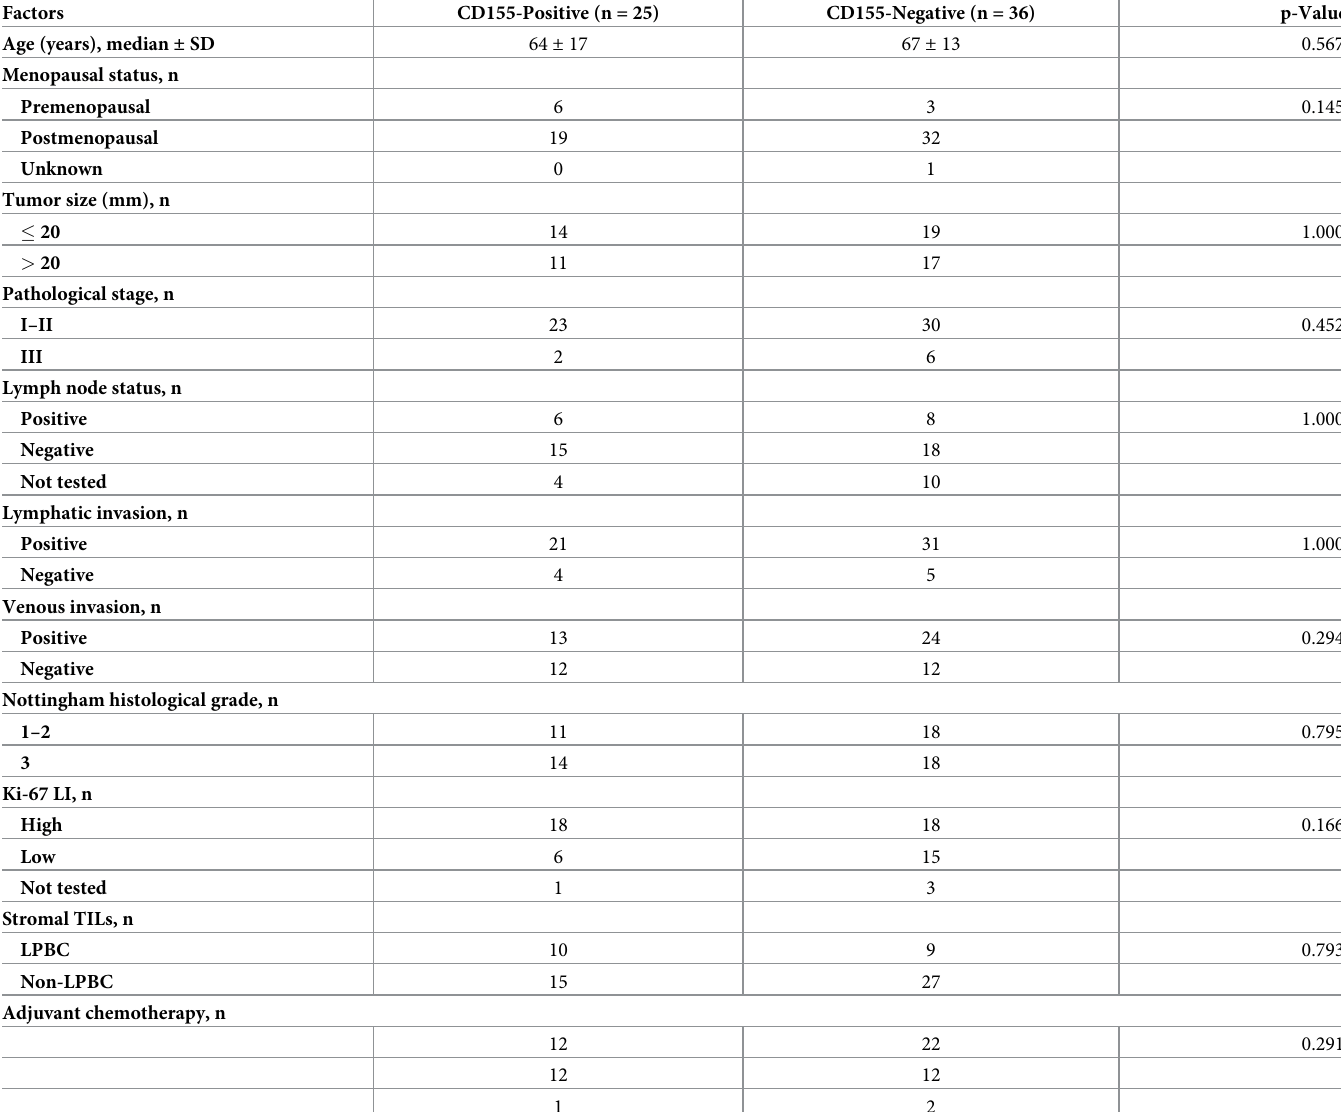
Table 2. Correlation between clinicopathological factors and CD155